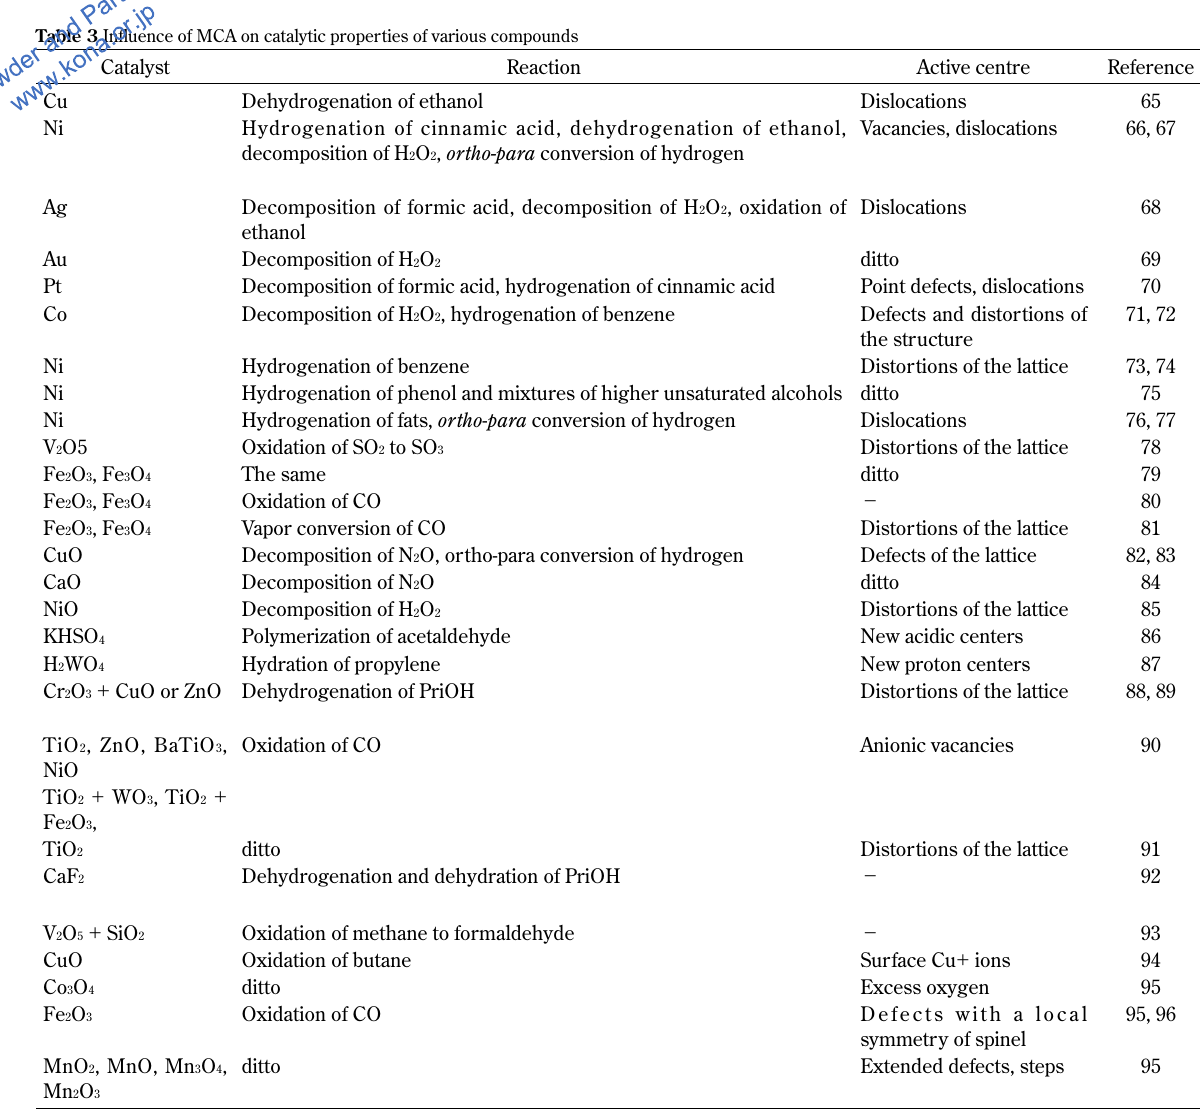
Table 3 Influence of MCA on catalytic properties of various compounds